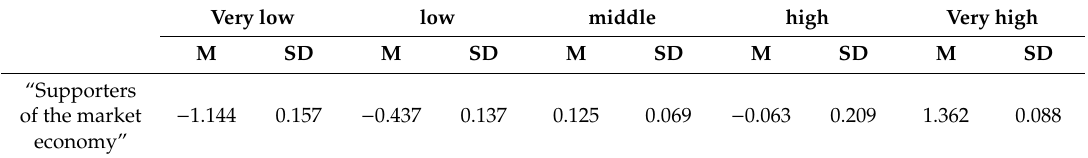
Table 3. Significant di ff erences between groups with di ff erent estimates of subjective revenue (N = 304). Very low